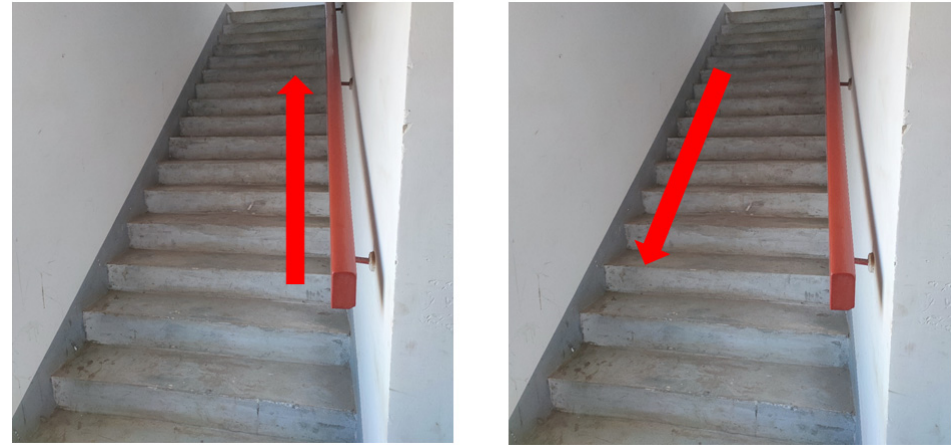
Figure 9. Experimental site of indoor altitude experiment.